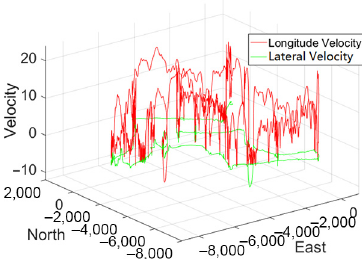
Figure 4 Longitudinal and lateral